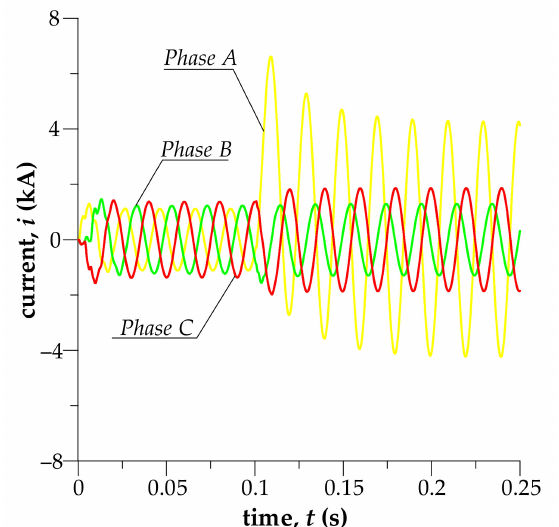
Figure 8. Transient currents in the middle line section for the first experiment.